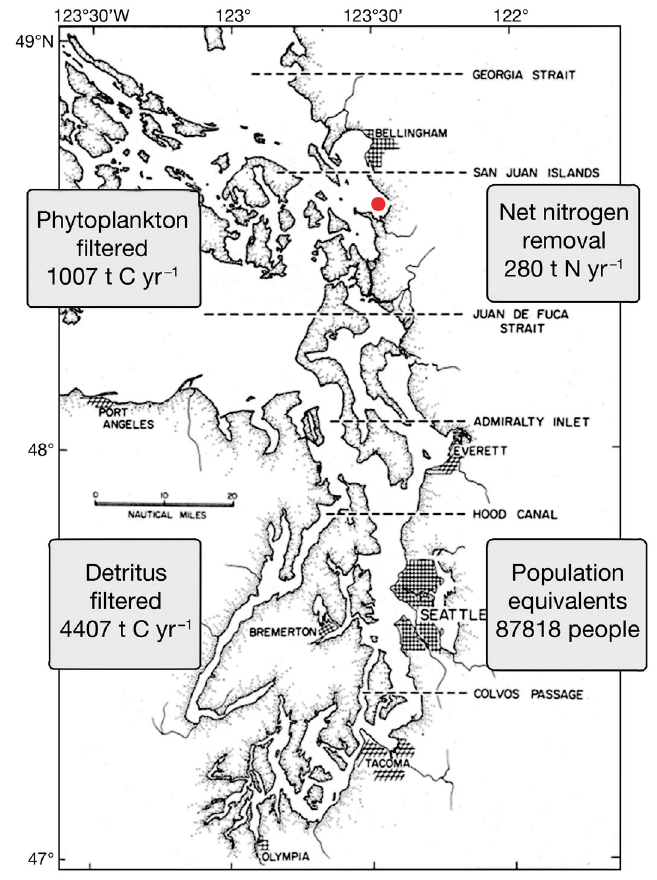
Fig. 12. Scaling of environmental externalities of clam cul- ture at Chuckanut Shellfish farm (red dot) to the total Manila clam production in Puget